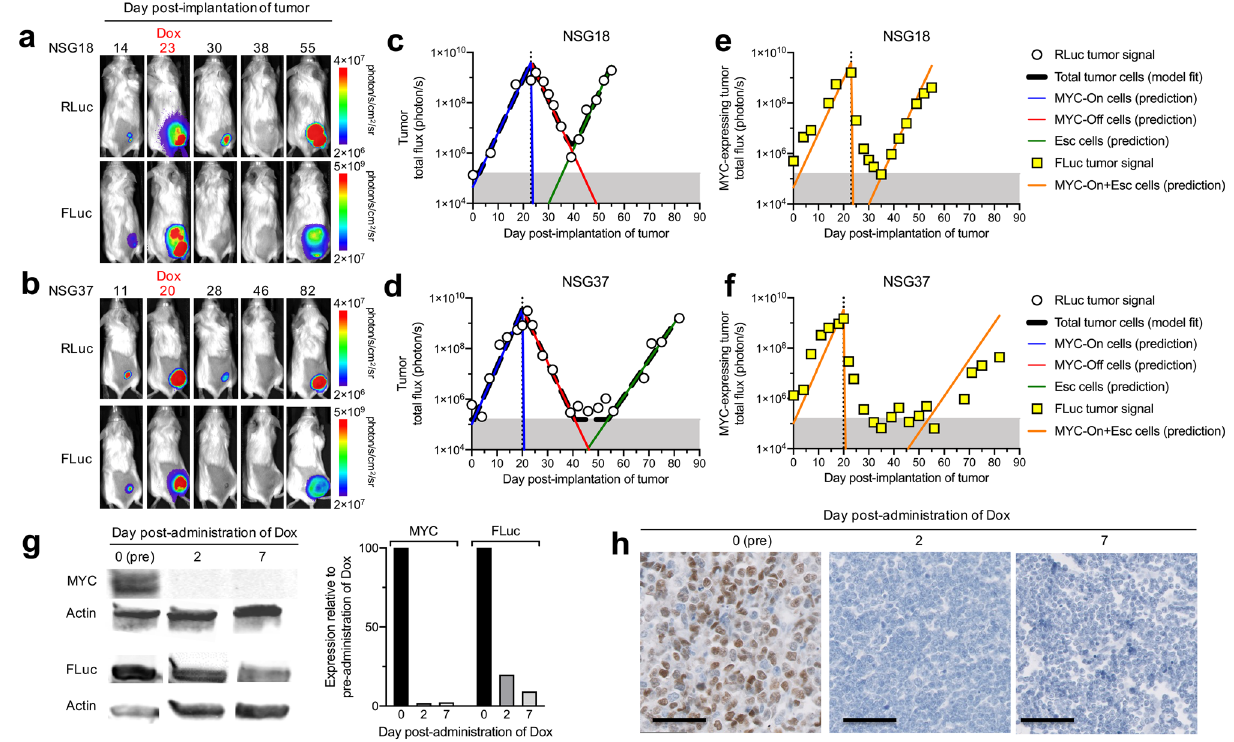
Figure 2. Modeling in vivo bioluminescence imaging (BLI) measurements of tumor burden in mice with recurring tumors. ( a , b ) BLI of PGK-RLuc and Tet-FLuc signals in two representative NSG mice treated with doxycycline (Dox) on ( a ) day 23 or ( b ) day 20 after tumor transplantation. ( c – f ) Quantitative analysis of the RLuc and FLuc signals from ( a , b ). ( c , d ) The simplified 3-compartment model was fitted (dashed black line) to RLuc signal (white circles), shown superimposed with the predicted population of MYC-On cells (blue line), MYC-Off cells (red line), and Escaped cells (green line). Shaded grey region (below 1.60 × 10 5 photon/s) indicates imaging signal is below the limit of detection. ( e , f ) The model-predicted MYC-expressing tumor cell population (orange line) superimposed with Tet-FLuc signal (yellow squares). ( g ) Western blot of MYC and FLuc protein expression in the tumors collected before, or 2 or 7 days after MYC inactivation. ( h ) Immunohistochemistry staining of MYC in the tumors collected before, or 2 or 7 days after MYC inactivation. Scale bar is 50